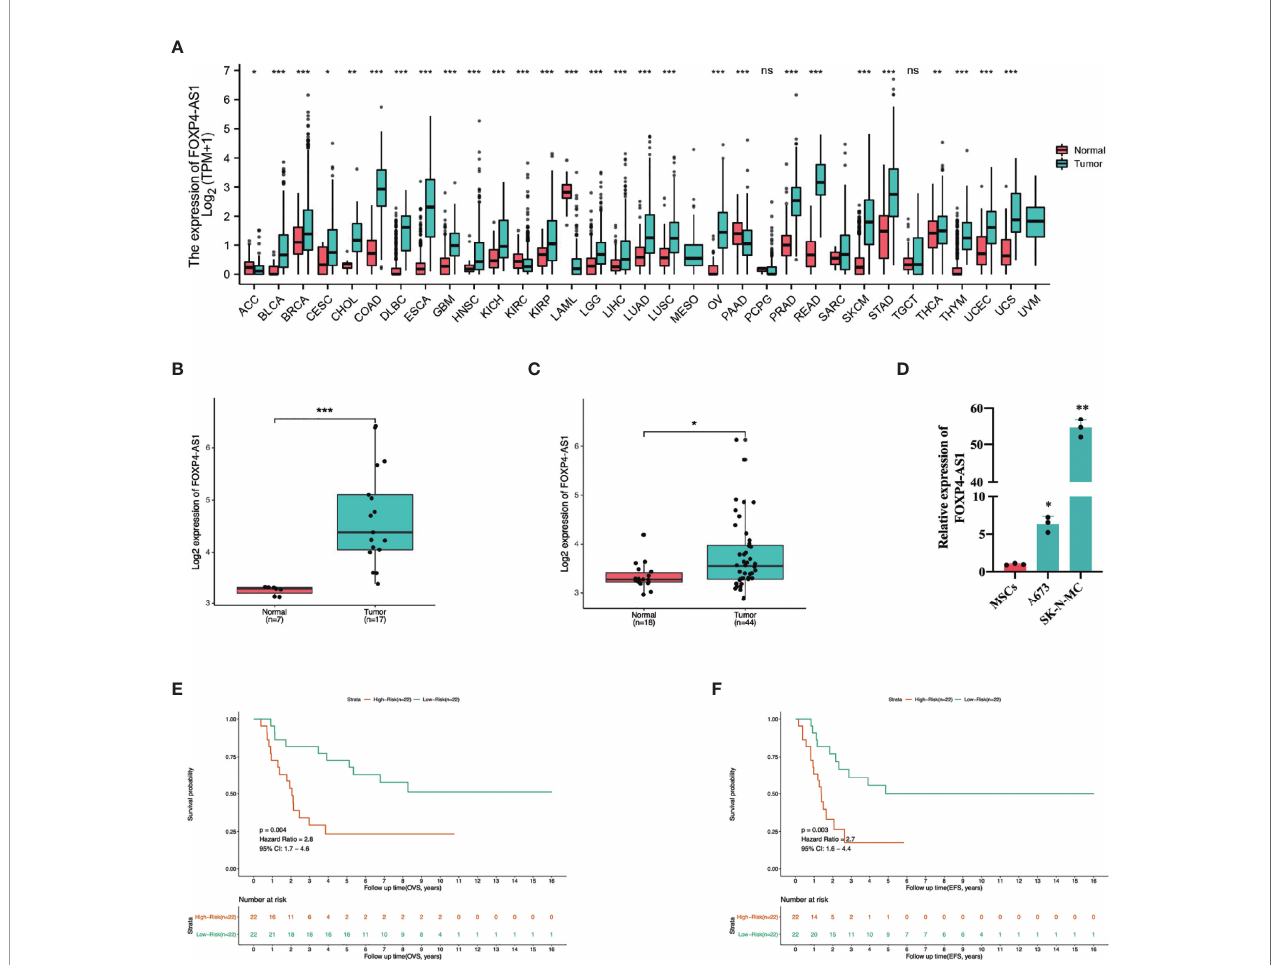
FIGURE 1 | Pro fi le of FOXP4-AS1 expression in ES and its association with poor prognosis. (A) Patter of FOXP4-AS1 expression in datasets from the TCGA and GTEx databases. (B, C) Patterns expression of FOXP4-AS1 in ES tissues and cells. (D) The contents of FOXP4-AS1 in ES cell lines A673 and SK-N-MC, detected via qRT-PCR. (E, F) Survival and univariate Cox regression analyses reveal the effect of FOXP4-AS1 expression on overall survival (OVS) and event-free survival (EFS) of ES patients. *p < 0.05, **p < 0.01, ***p < 0.001, ns, non-signi fi